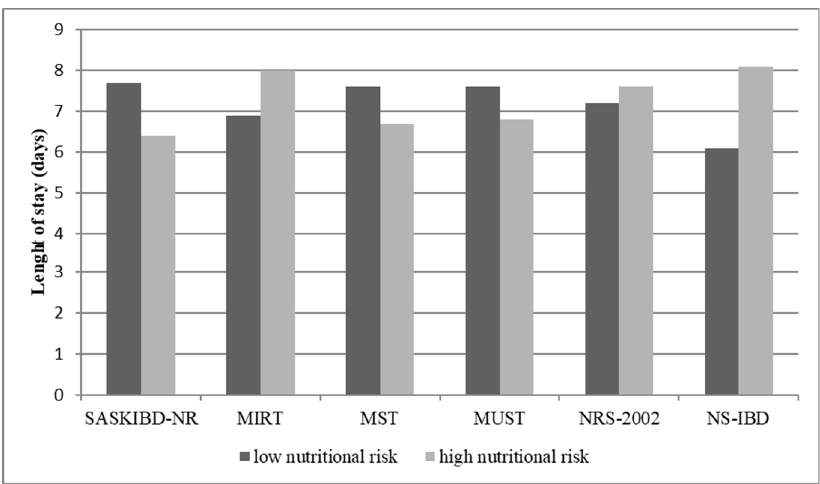
Figure 3. Nutritional screening results in relationship to the length of stay.